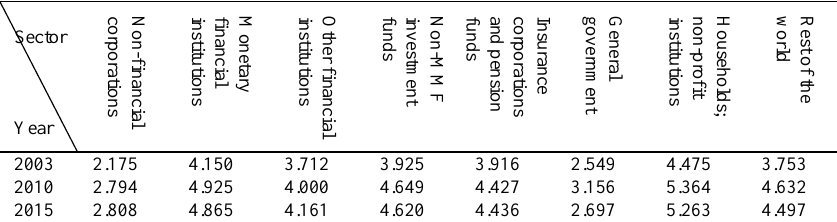
Table 3. Total multipliers measuring the effects of growth in net lending of individual institutional sectors on the basis of the financial input-output tables for Poland